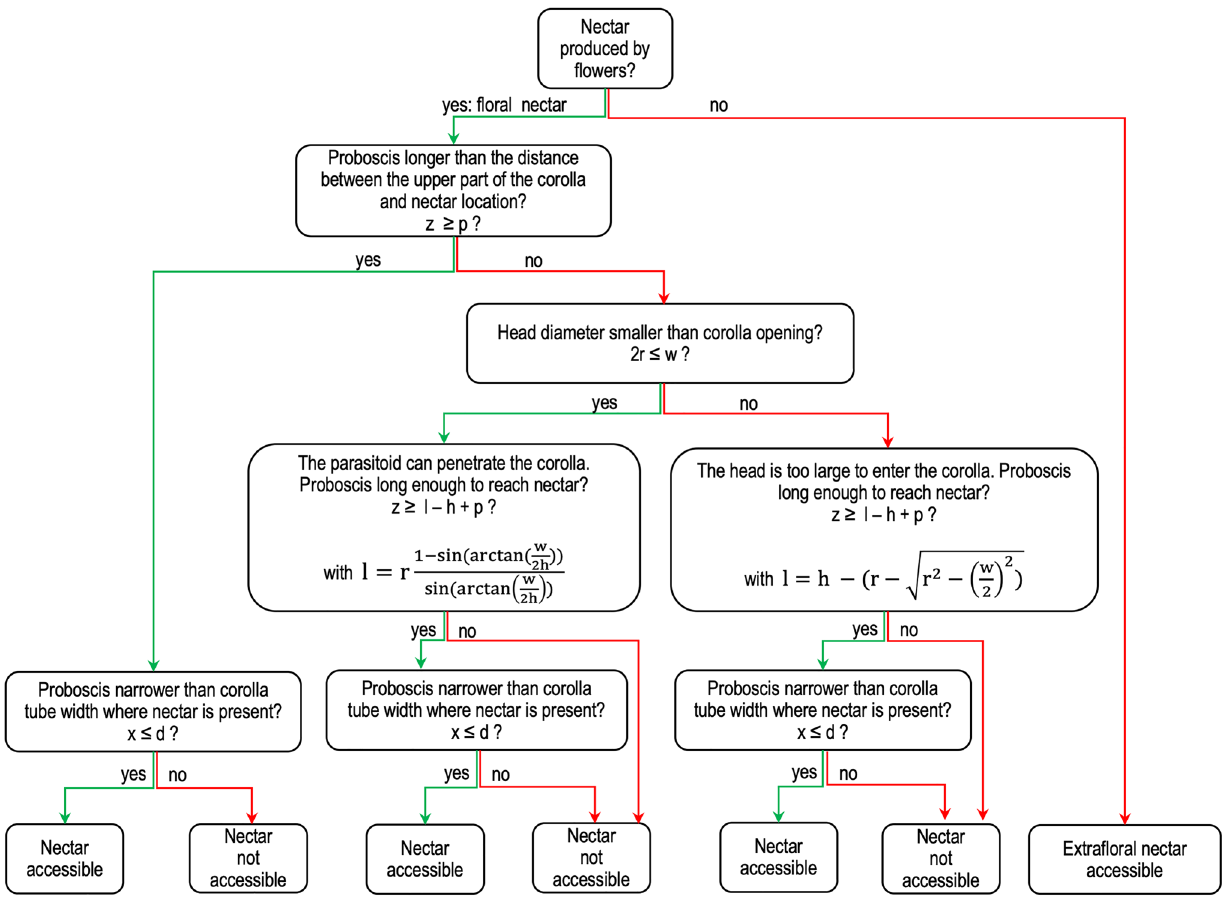
Figure 2. Decision tree used to determine the accessibility of nectar to insects as a function of insect traits (radius of insect head r, proboscis length x and proboscis width z ) and flower traits (width of flower opening w , corolla height h , nectar depth p , nectar tube diameter d ). More information can be found in the Supplementary methods. This figure was re-drawn from Zucchetta 29 , and it was created using Microsoft Powerpoint version 16.16.14 (https:// www. micro soft.